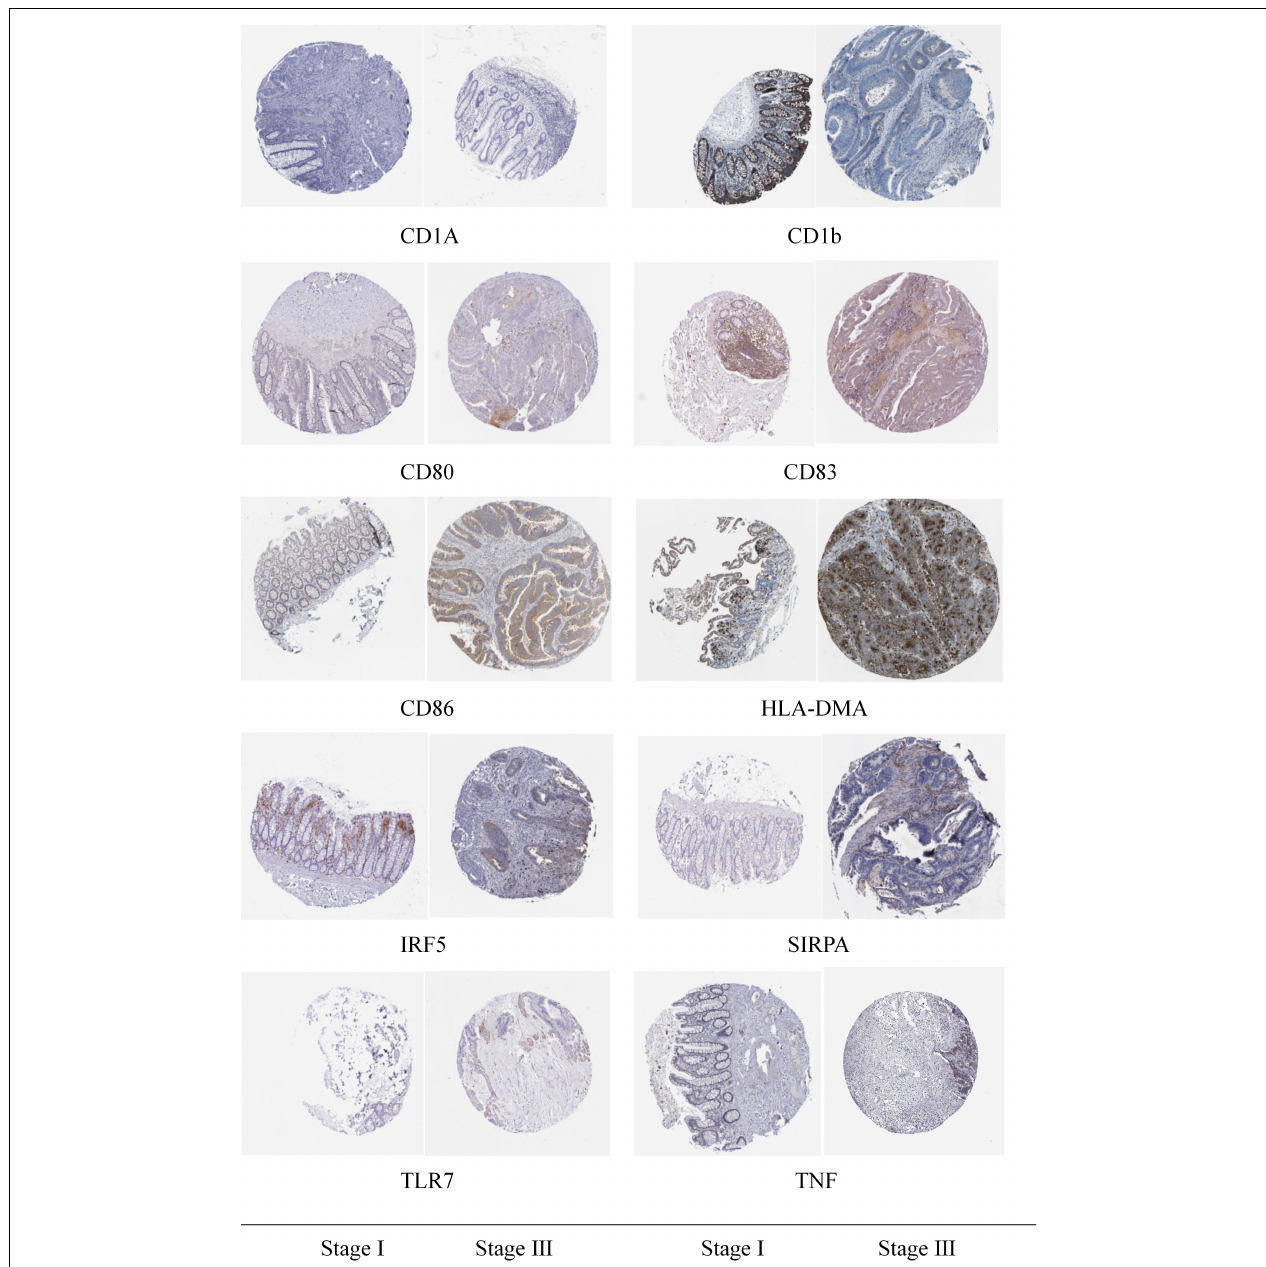
FIGURE 10 | Immunohistochemical detection results of the marker genes of M1 macrophages and dendritic